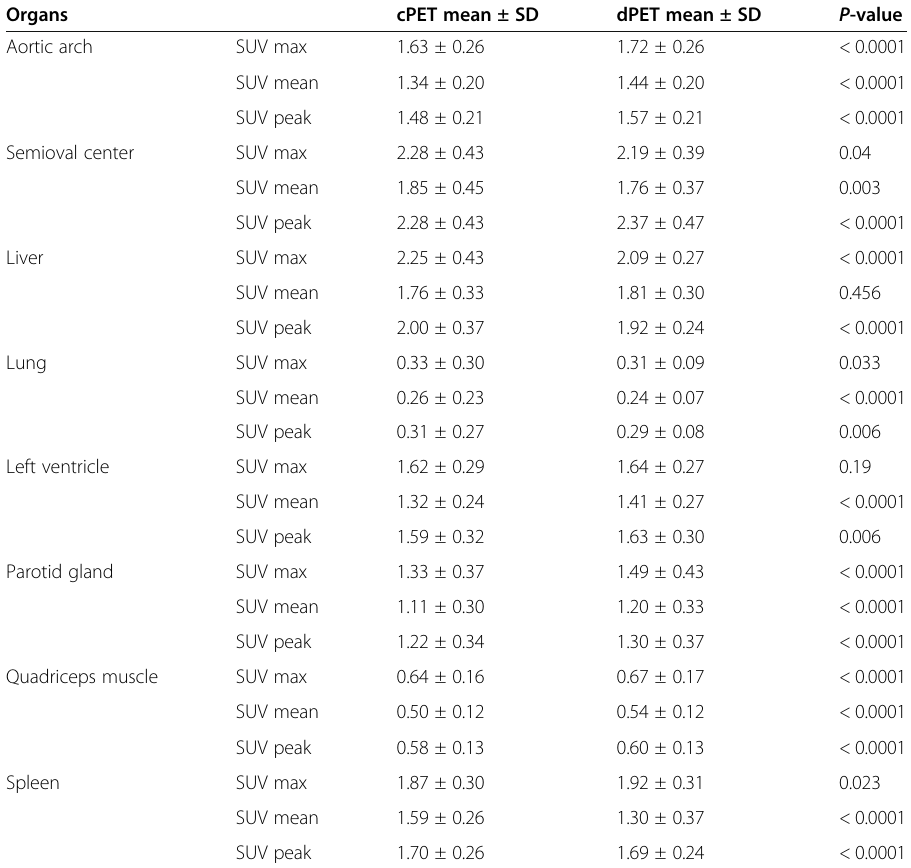
Table 3 SUVs in healthy organ tissues Organs